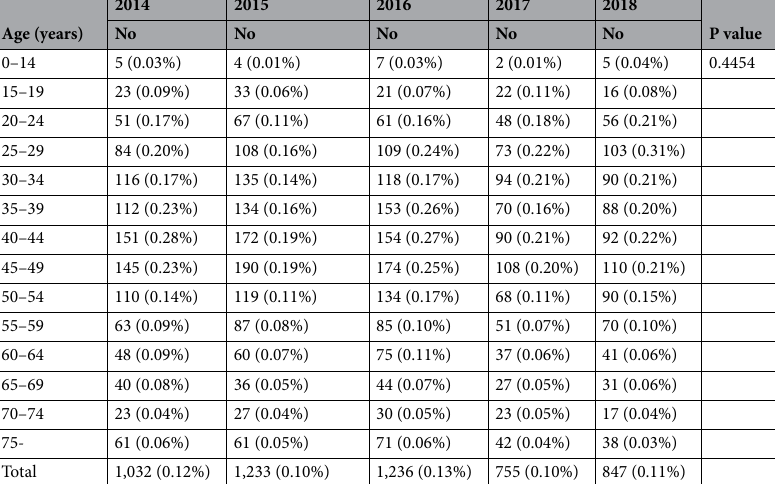
Table 3. Age-specific prevalence rates of borderline ovarian tumors from 2014 to 2018 stratified according to 5-year age increments.